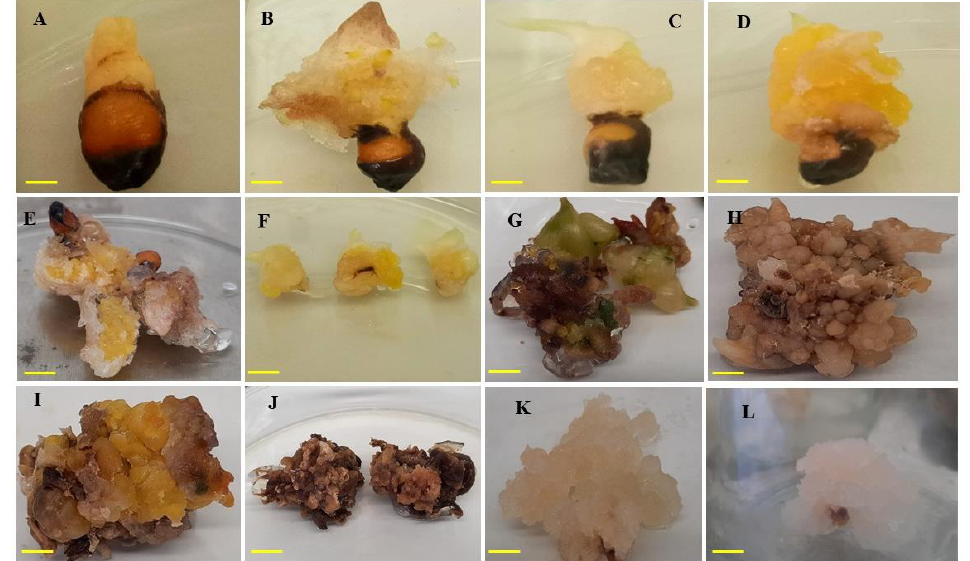
Figure 5. Callus formation on MS media fortified with IAA and PIC alone or in combination with BAP. ( A ) Compact callus induced with 1-mg L − 1 IAA; ( B ) yellowish compact callus induced with 2-mg L − 1 IAA; ( C ) and ( D ) yellowish friable callus induced with 3-mg L − 1 IAA; ( E ) brownish-yellow callus friable texture induced with 3-mg L − 1 PIC; ( F ) callus obtained from 3-mg L − 1 IAA and further used for callus proliferation; ( G – J ) brown callus from second subculture using combination of IAA with BAP; ( K – L ) friable callus from second subculture. Bar = 1 cm.